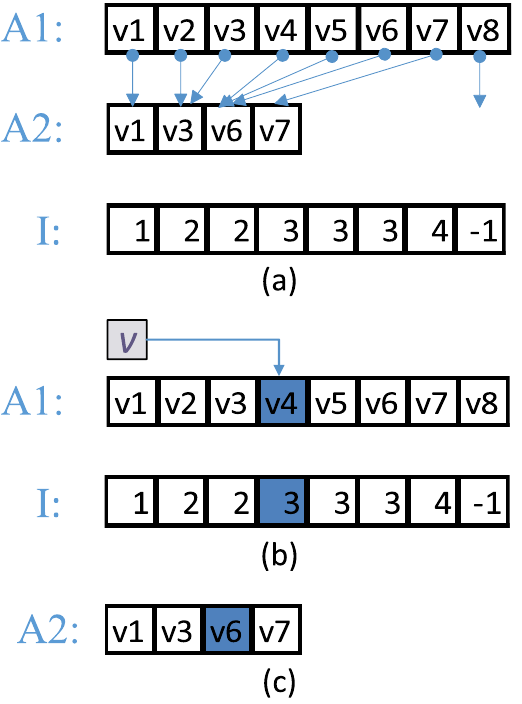
Figure 3. A simple example of search by fractional cascading. Given a value v , the query searches for the minimum values no less than v in A1 and A2 respectively. ( a ) Create the indexing array I from A1 to A2. Refer to such an index as FC-index. ( b ) Suppose v ∈ ( v 3, v 4], the binary search for v from A1 will return v 4 and its position 4, then the corresponding FC-index in A2 is I [4] = 3. ( c ) Directly return A 2[ I [4]] = v 6 as the search result from